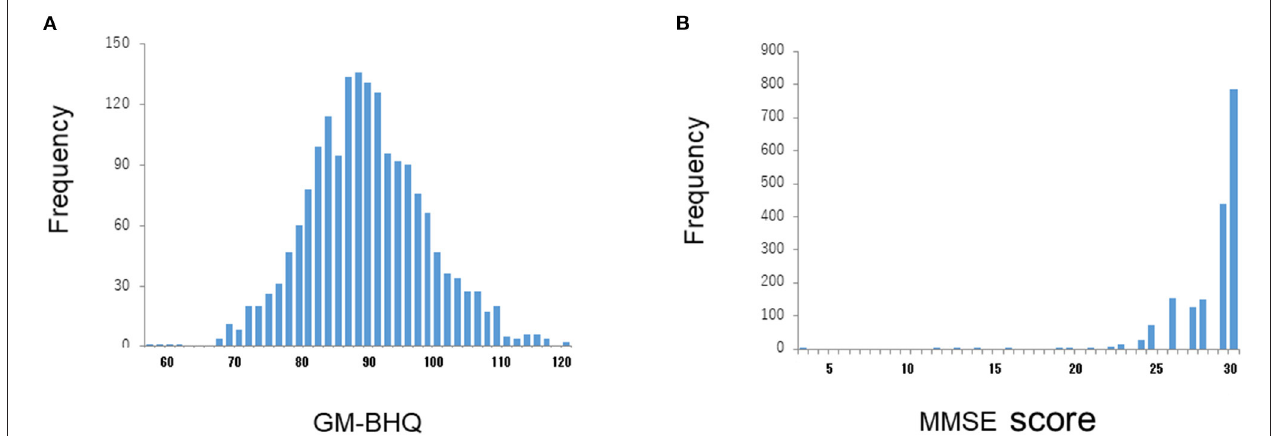
FIGURE 1 | Distributions of GM-BHQ and MMSE scores. The vertical axis reflects the number of cases, while the horizontal axis indicates the GM-BHQ (A) and MMSE scores (B) , respectively.